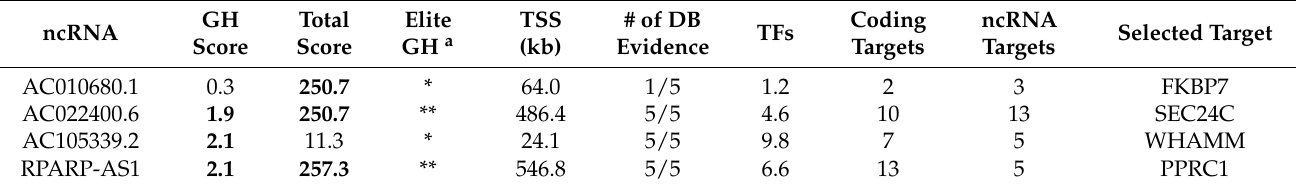
Table 2. ncRNA upregulated by ladostigil treatment under oxidative stress